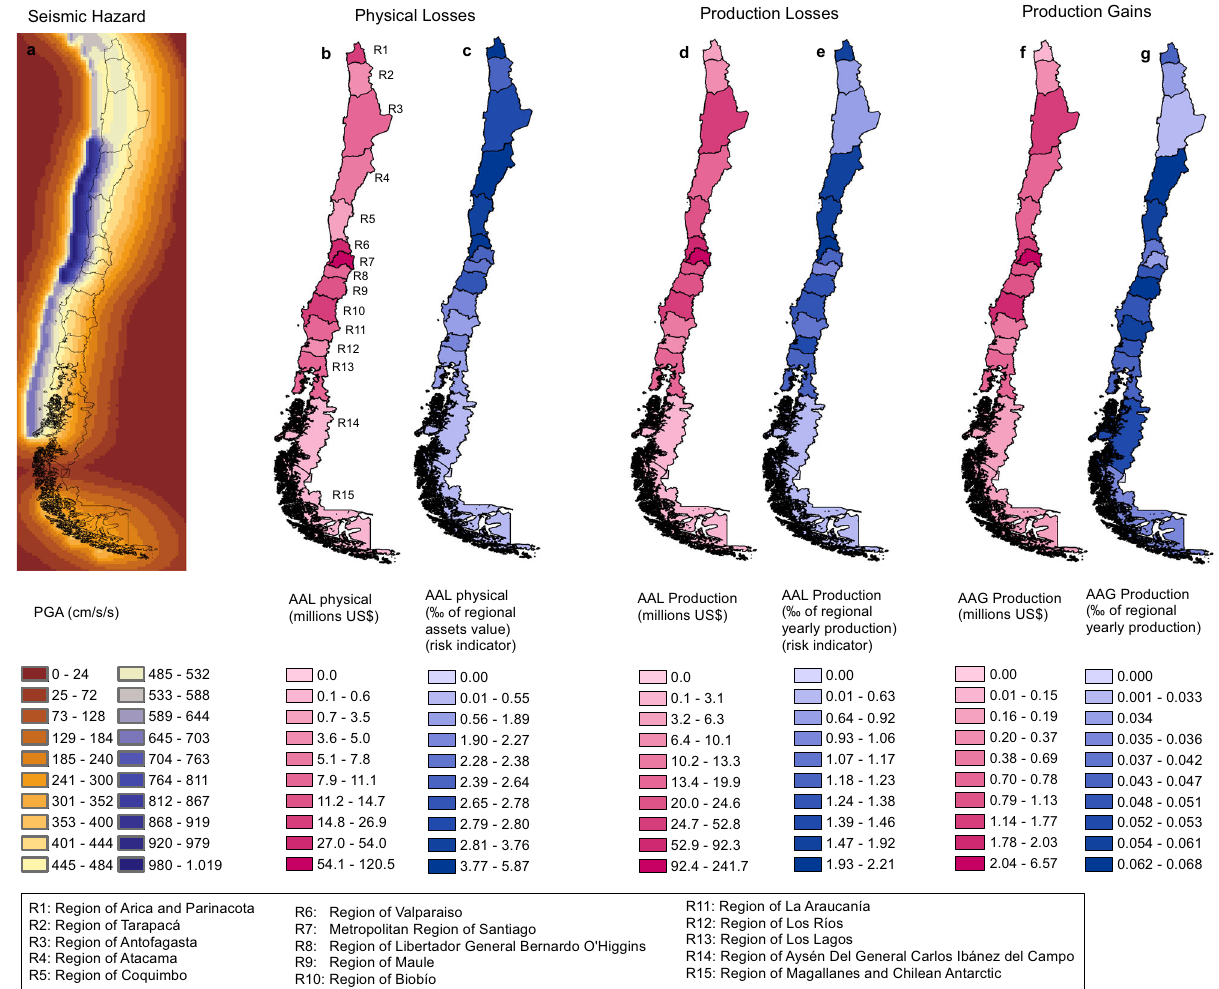
Fig. 3 Distribution of Average Annual Loss (AAL) in Chile. a Shows the seismic hazard for Chile, expressed in terms of the Peak Ground Acceleration (PGA) associated with 475 years of return period. The average annual loss due to physical damage of non-residential buildings (direct losses) by region is shown in ( b ) in millions of USD and ( c ) as a fraction (per thousand) of its regional exposed value. The average annual loss in production by region is shown in ( d ) in millions of USD and ( e ) as a fraction (per thousand) of the corresponding regional annual production. Finally, ( f , g ) present the Annual Average Gain (AAG) of production by region, due to substitution effects, in millions of USD and as a fraction (per thousand) of the corresponding regional annual production. AAL is presented as a fraction (per thousand) of its corresponding exposed value to see how risky each region